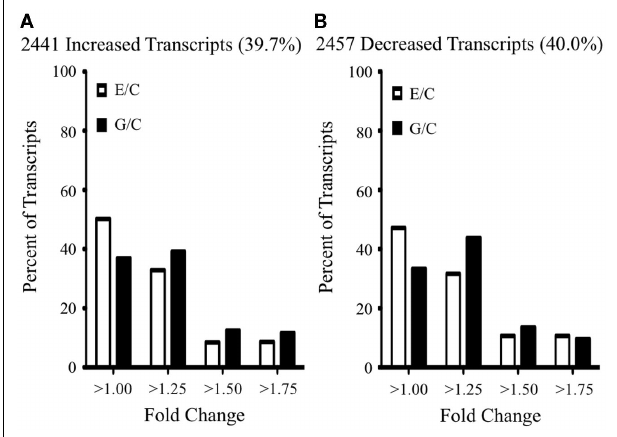
FIGURE 2 | Summary of NURR1 effects on profiles of gene expression. The abundances of > 6000 transcripts were significantly altered as a function of increasing NURR1 concentrations across SK-N-AS-derived clonal lines (i.e., C → E → G lines).Transcripts exhibiting a unidirectional response to increasing NURR1 [i.e., increased in E and G (A) or decreased in E and G (B) , relative to C] are characterized by distributions of effect sizes (fold-change plotted on x axis, percent of transcripts with corresponding change plotted on y axis). Not shown are the one-fifth of NURR1-responsive transcripts that exhibited bidirectional changes with increasing nurr1 expression (i.e., different directions of change in E and G, relative to C; see Table S1 in Supplementary Material for supporting expression